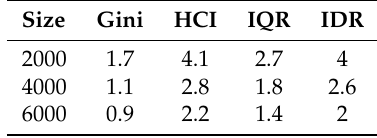
Table 5. Relative standard deviation (%) of each parameter applying PSA with the stratified reference sample.